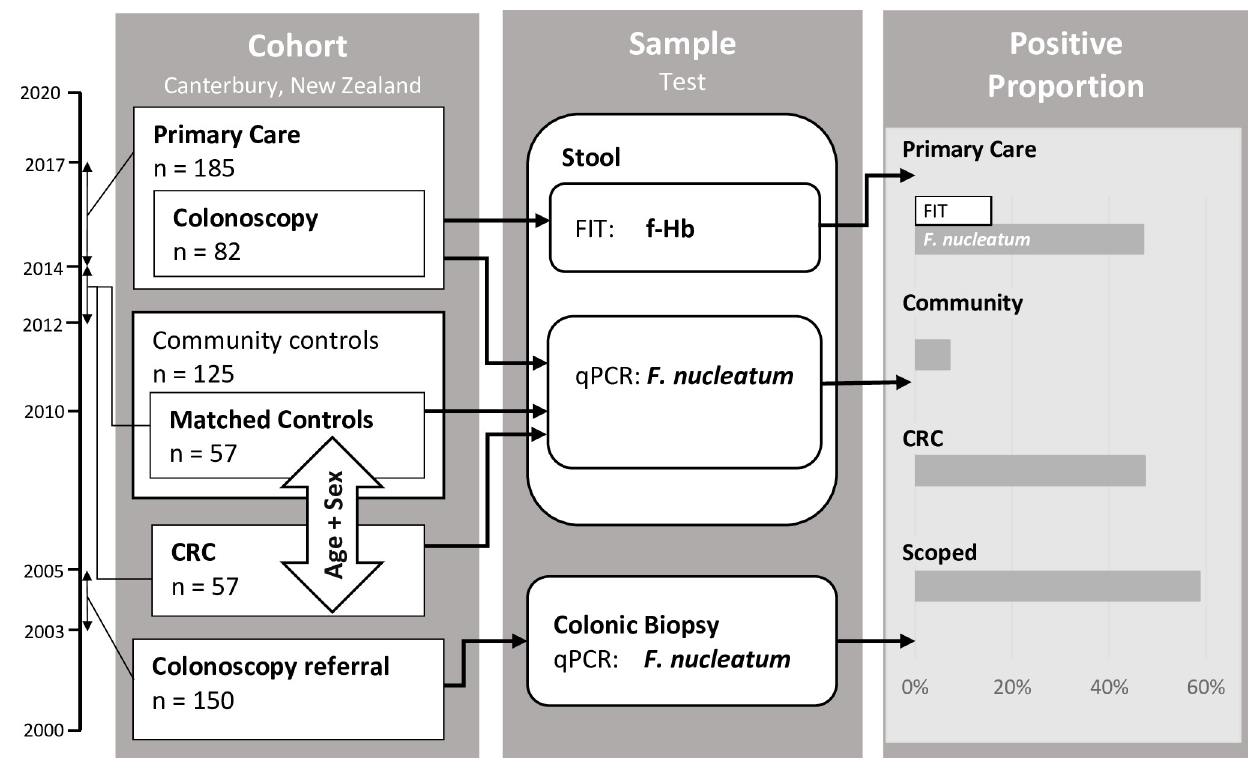
Fig 1. Schematic of study design. Left panel, the four cohorts used in the study with approximate years of collection indicated on the far left; centre panel, analyses performed on cohorts; right panel, graphic representation of results of analyses for each cohort.